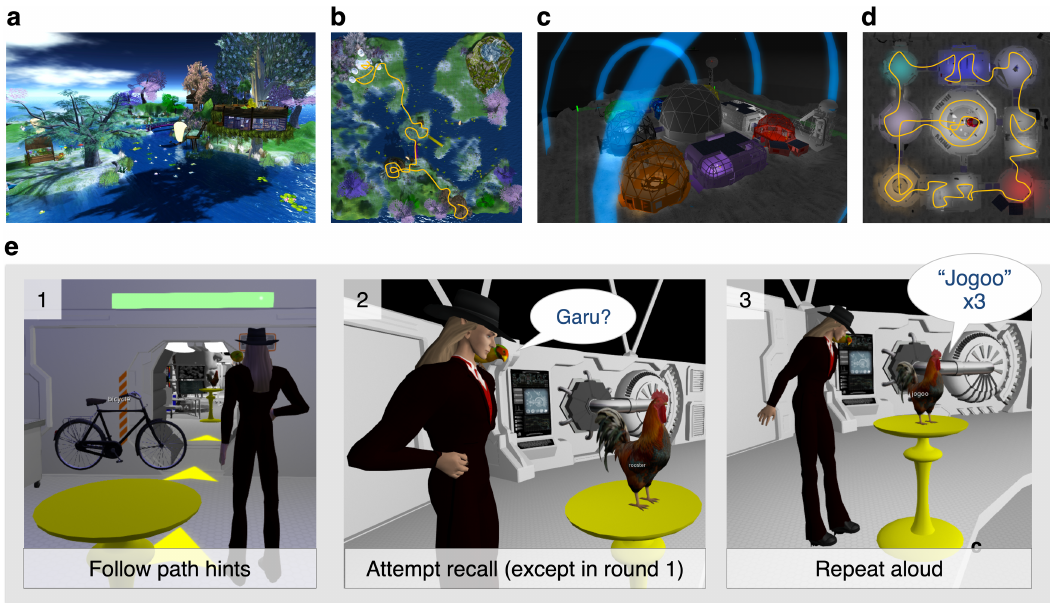
Fig. 2 Distinctive VR-based contexts and language encoding task. Two custom-built VR-based contexts were used in this study. a “ Fairyland Garden ” was a fantasy- fi ction inspired context that was bright, verdant, visually open, with lakes and wooden rooms opened to the outdoors. b Fairyland Garden ’ s predetermined path used in language encoding. This path ’ s hints were bright green footsteps; its pedestals tree stumps. c “ Moon Base ” was a science- fi ction inspired context that was dark, rocky, closed-in, with narrow hallways and arti fi cially coloured metallic rooms, and participants were con fi ned indoors at all times. d Moon Base ’ s predetermined path used in language encoding. This path ’ s hints were bright yellow arrows; its pedestals yellow stands as shown in 2e. e Language encoding task. In each round of language encoding, participants interacted with 40 concrete objects representing each of the foreign words (e.g., a rooster), organised along a predetermined path. The VR environments were experienced through a fi rst-person perspective (a visible avatar is only present in this fi gure for illustrative